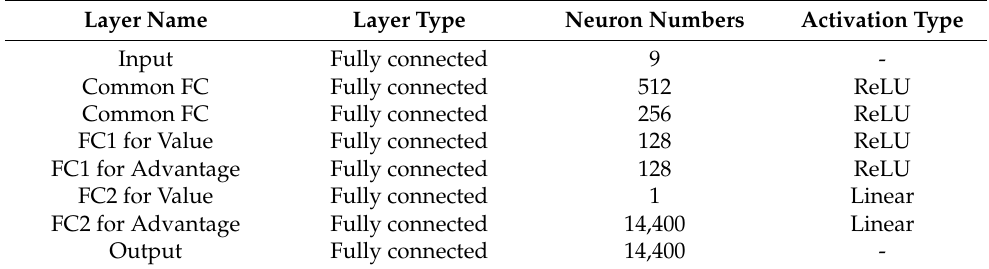
Table 4. The layer structure of D3QN.